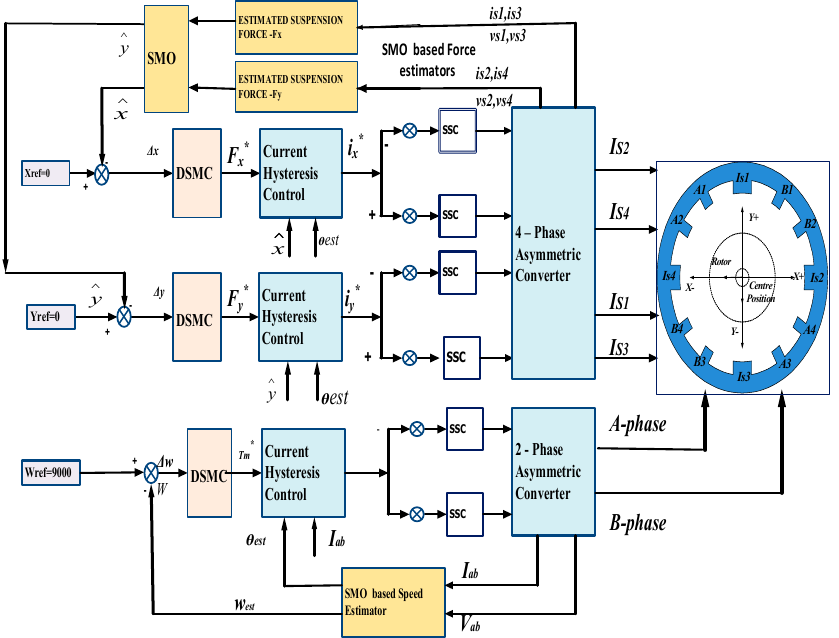
Figure 6. Overall sensorless control block diagram of the BSRM.